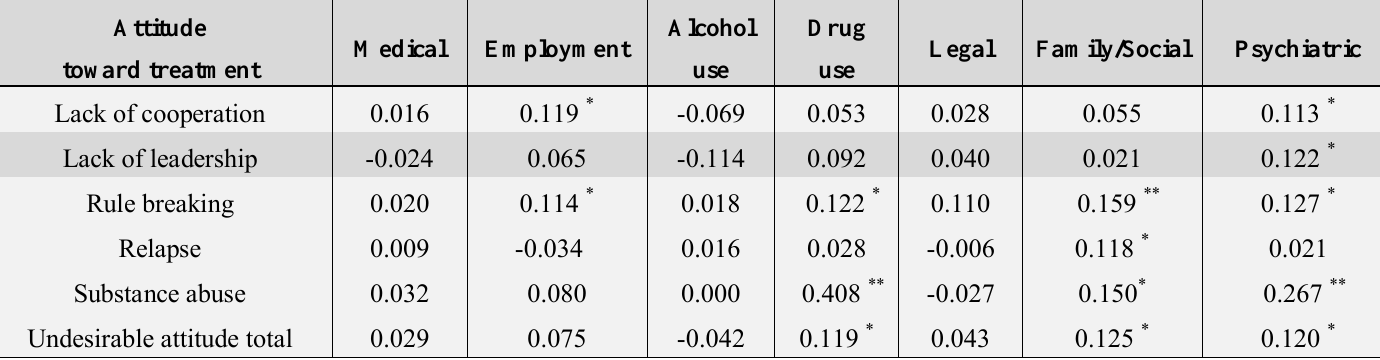
Table 2. Correlation coefficients between CSs and attitudes toward treatment in alcohol-dependent